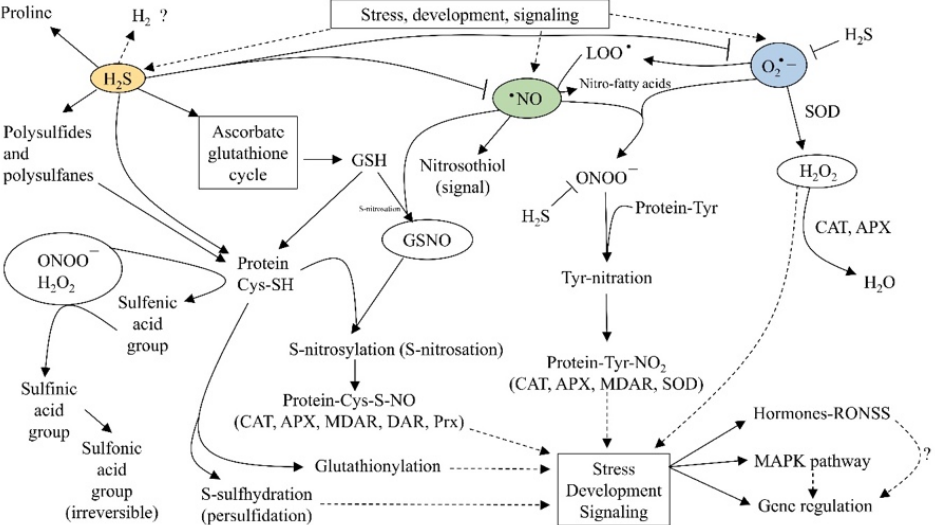
Figure 5. A simplified model of the interactive action of ROS, RNS, and RSS (RONSS) on plant responses during development events or stress-inducing environmental challenges.